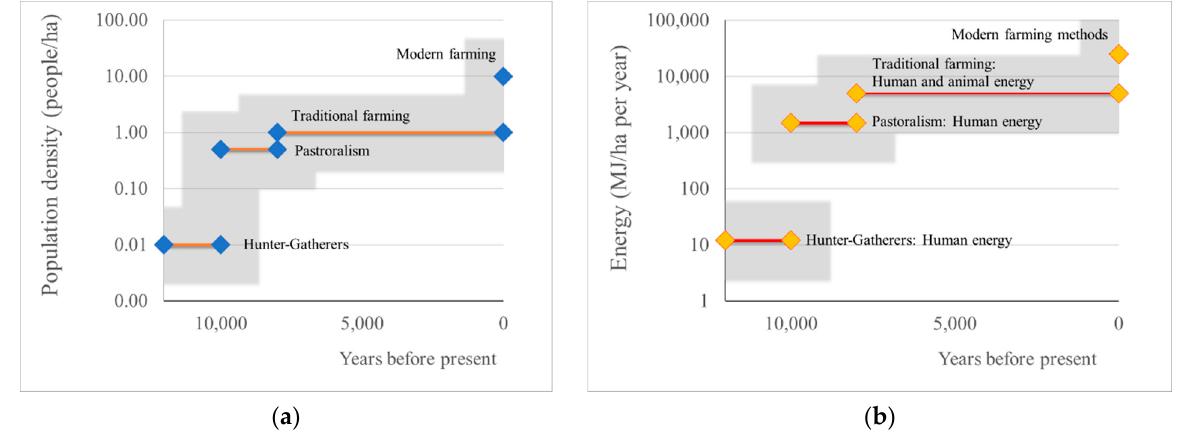
Figure 8. Typical types of food production in different eras related to: ( a ) population density; ( b ) energy needs (diagrams present data as order of magnitude) [75,76,79–87].